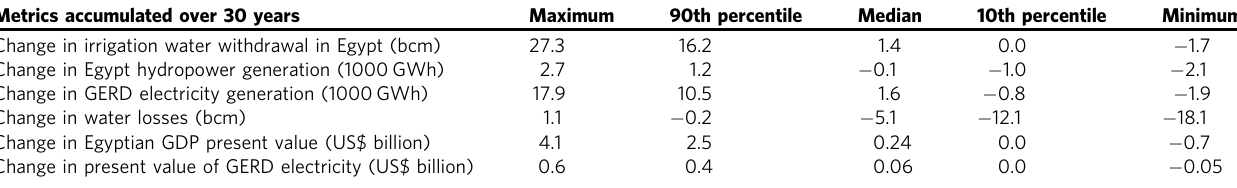
Positive values indicate higher simulated results with the coordinated